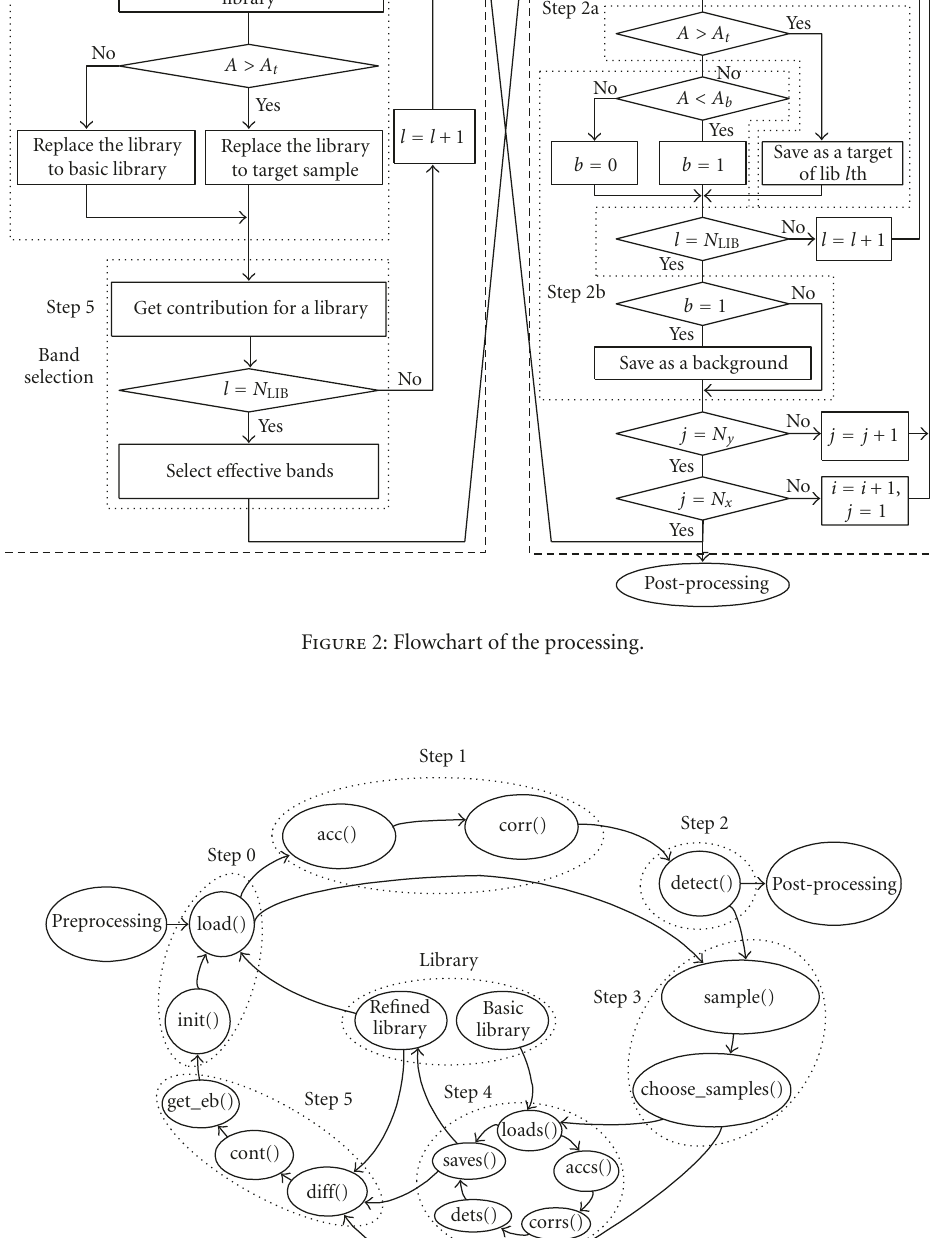
Figure 3: Illustration of functional